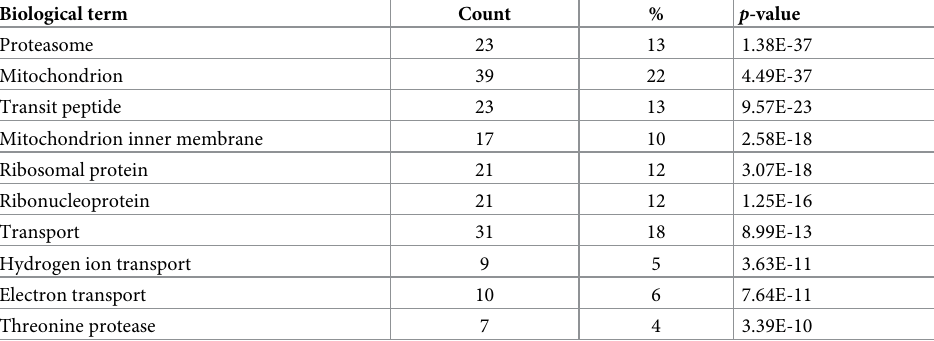
Table 1. Top 10 enriched biological terms for the 179 genes that increased Pnhr-57 ::GFP expression when knocked-down by